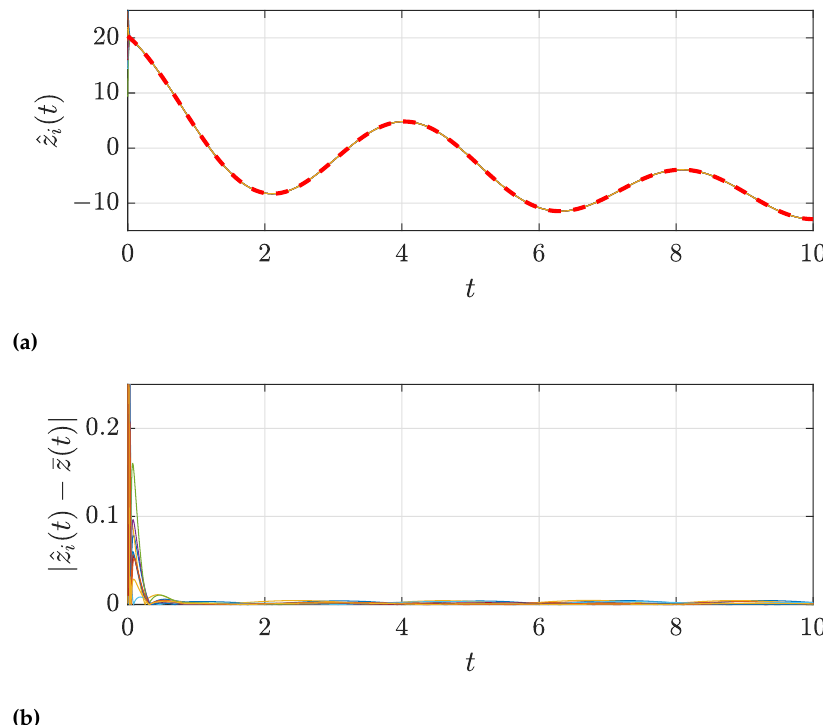
Figure 3. Consensus results for our protocol with ∆ = 10 − 4 , ε = 0 (full communication). By using a small time step and communication at every step, our protocol obtains highly precise results. ( a ) Consensus estimates for the average signal using our proposal. The desired value ¯ z ( t ) is plotted as a dashed red line. The estimates quickly converge to the average signal. ( b ) Consensus error of the estimates with respect to the average signal. The error converges to a neighbourhood of zero, which can be made arbitrarily small by tuning the value of the sampling